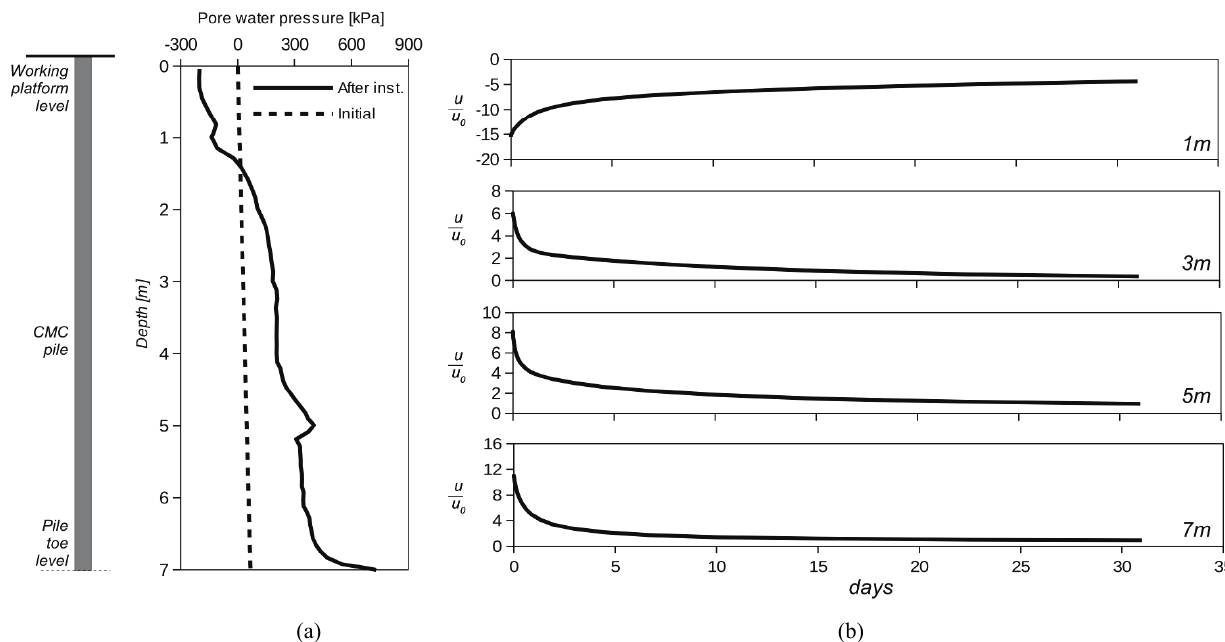
Fig. 9. (a) Pore water pressure distribution along pile wall after installation,